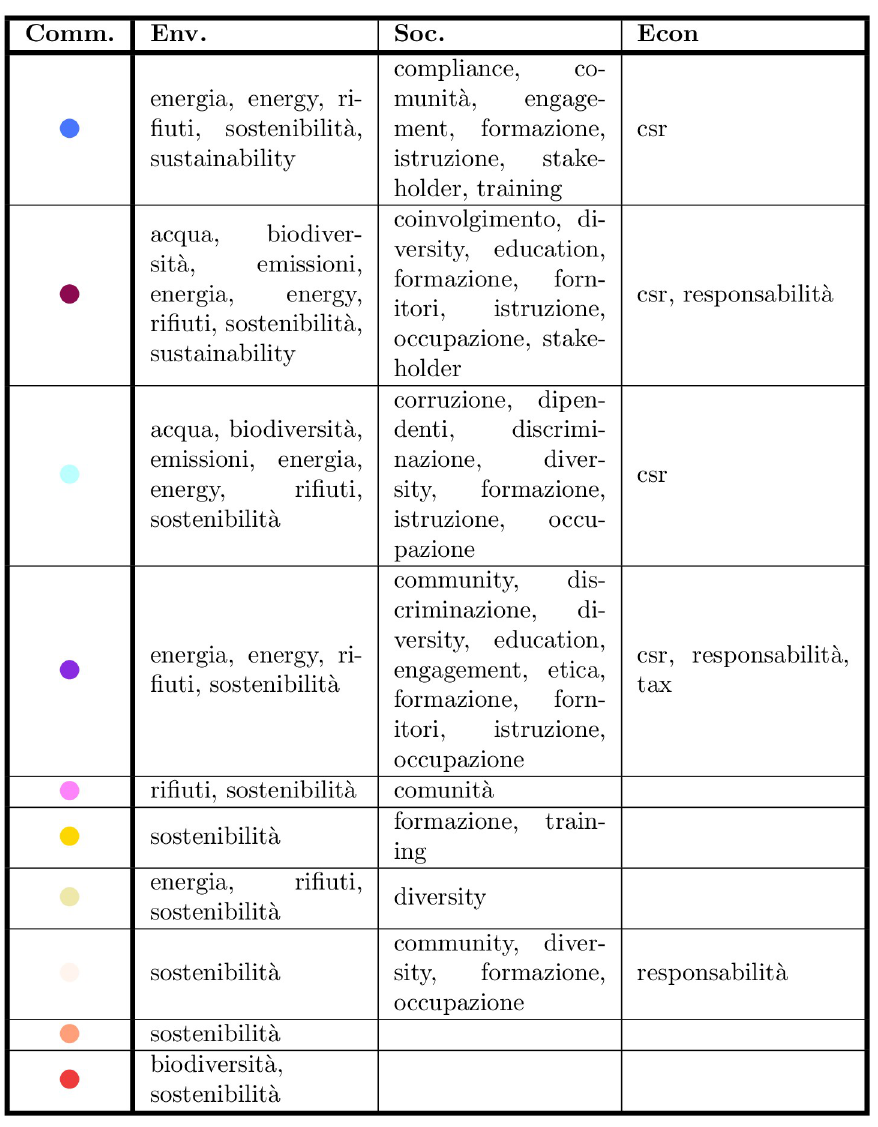
Fig 13. CSR keywords per community. As expected, the various CSR dimensions used depends on the ATECO sectors covered by the community.